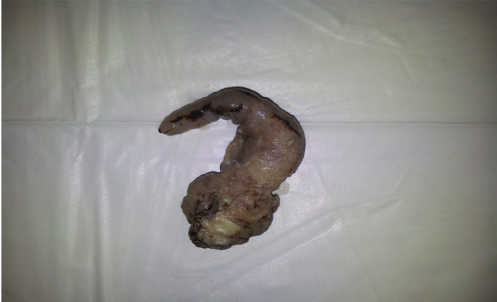
Figure 1: Right Fallopian tube: swollen, edematous with early signs of necrosis.